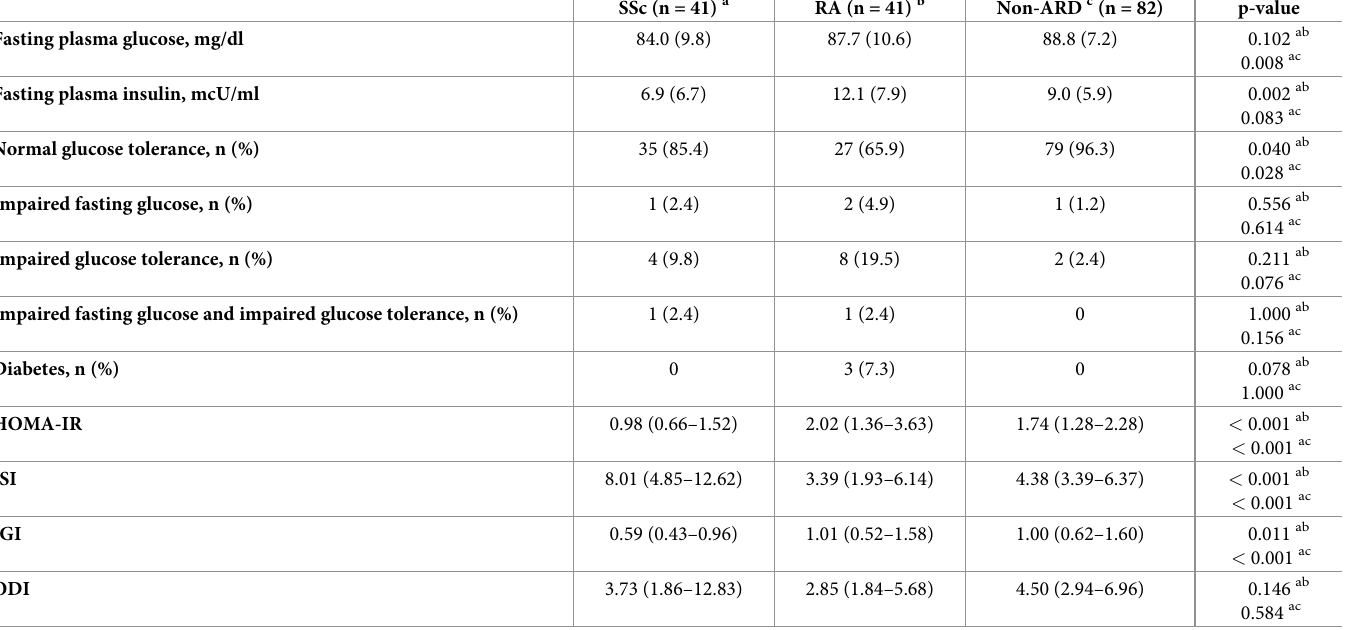
Table 2. Glucose metabolism in SSc and